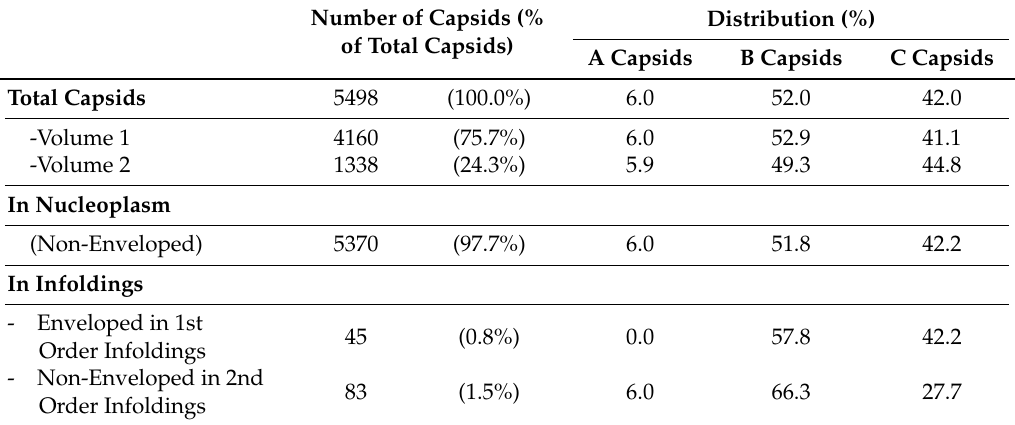
Table 1. Quantification of capsids in volume 1 and 2. The total number of capsids in volume 1 was approximately three times higher than in volume 2 but the ratios of the three capsid types were similar. 97.7% of the total capsids were located within the nucleoplasm. The ratios of A, B and C capsids are given for the nucleoplasm and the infoldings. The capsids in the infoldings were again divided into enveloped capsids in 1st order infoldings and non-enveloped capsids in 2nd order